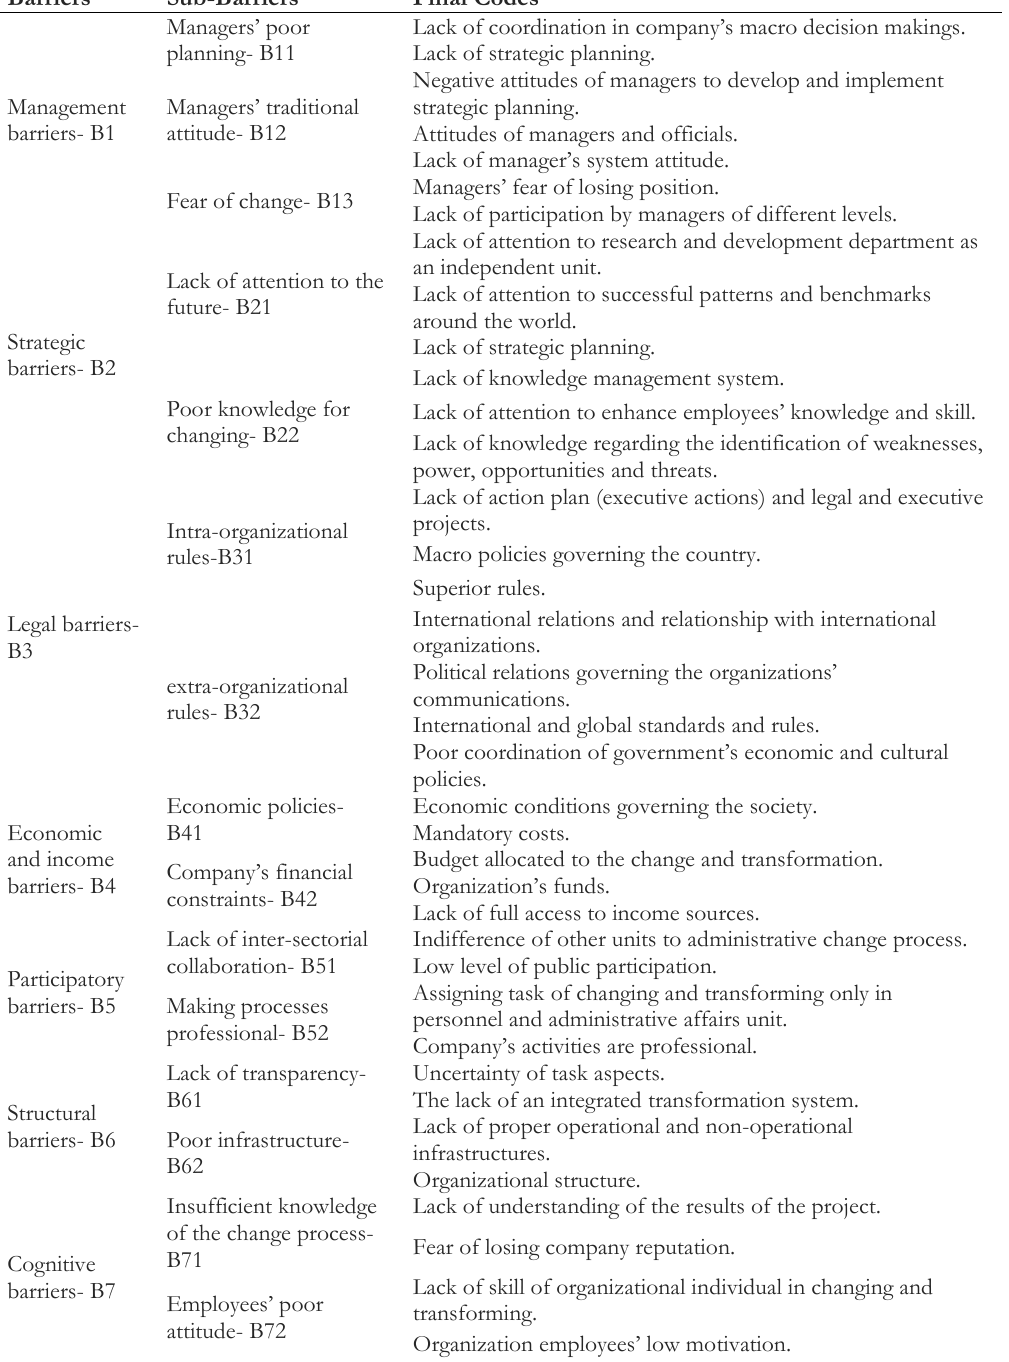
Table 6. Identified concepts and categories associated with executive barriers.